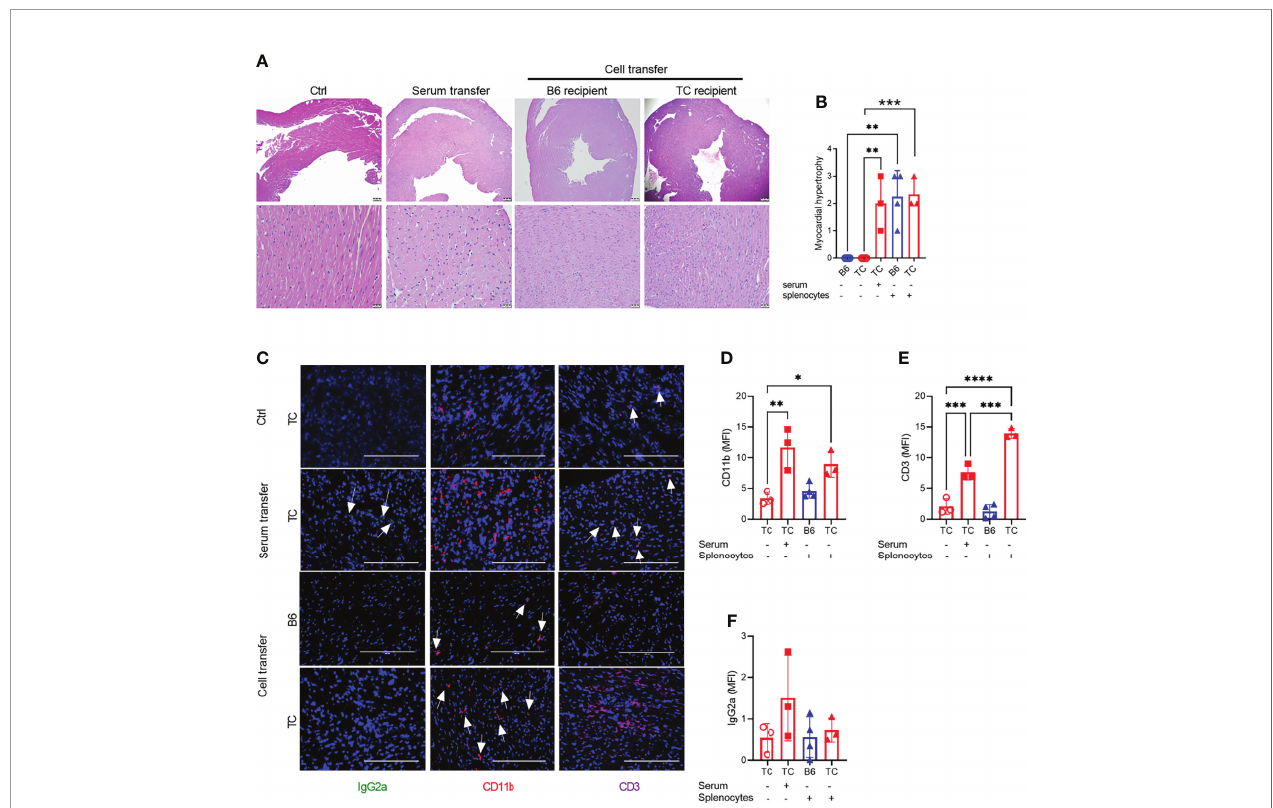
FIGURE 3 | Splenocytes or serum from R848-treated TC mice induced a reactive cardio-hypertrophy in B6 and TC recipients. (A) Representative H&E-stained heart sections of the indicated groups (top: 4X, scale bars 200um, and bottom: 40X, scale bars 20 um). (B) Myocardial hypertrophy scores. (C) Representative heart sections from TC controls as well as TC recipients of serum or splenocytes, and B6 recipients of splenocytes stained for IgG2a, CD11b and CD3 (20X, scale bars: 200 um). Quanti fi cation (MFI) of CD11b + (D) and CD3 + (E) cells and IgG2a deposits (F) . n = 3 - 4 per group. 1-way ANOVA with multiple comparison tests, * P < 0.05, ** P < 0.01, *** P < 0.001; **** P <